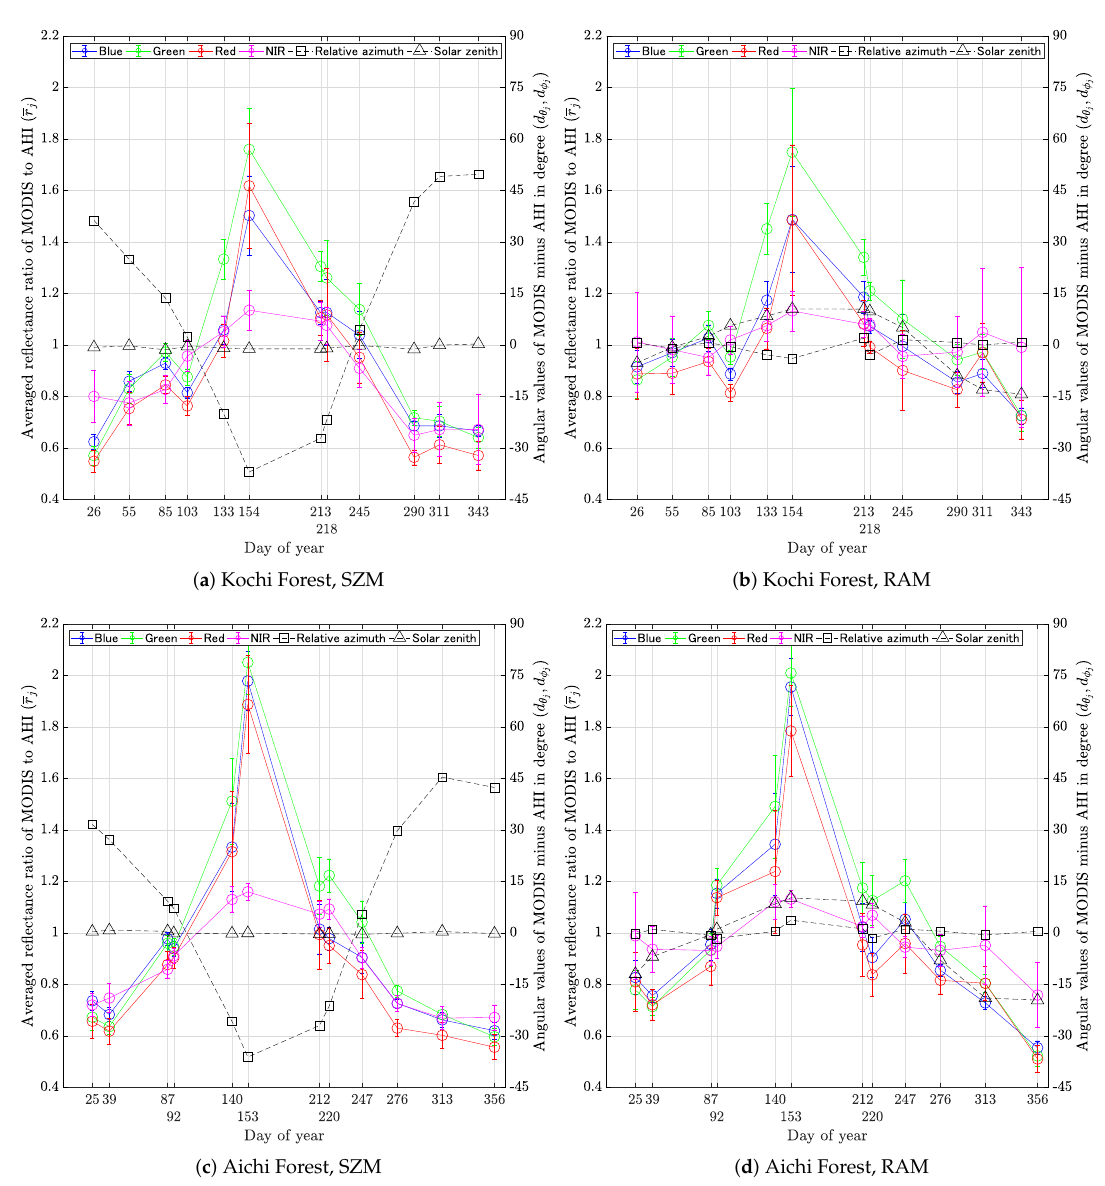
Figure 6b. A comparison of Figure 6a,b reveals that the value of r j was closer to unity for the RAM method. This improvement was obtained by adjusting the relative azimuth angle in the RAM method.